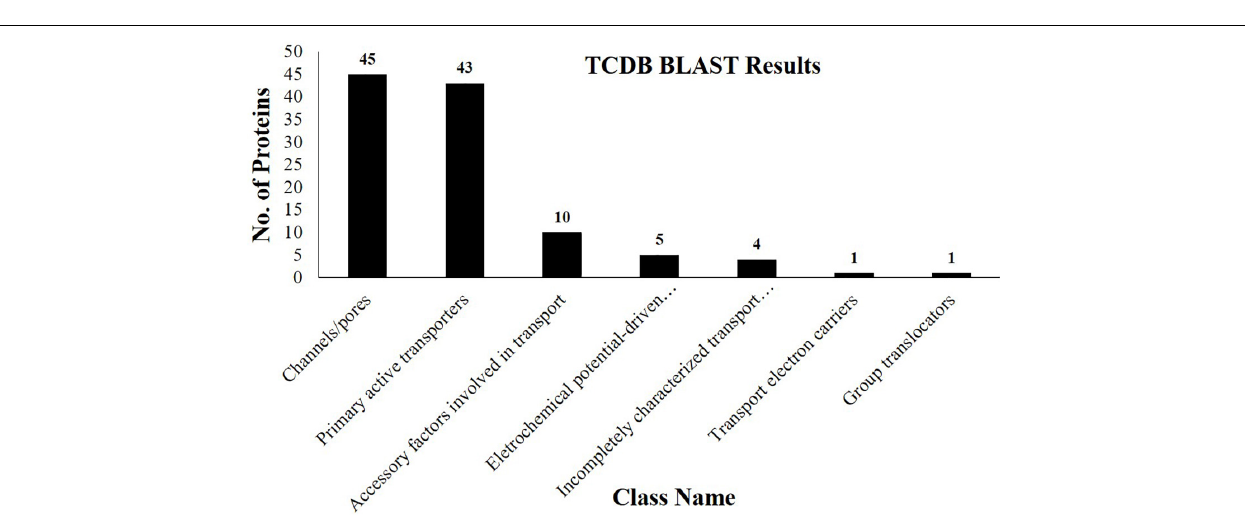
FIGURE 4 | Column graph showing the various classes of transporter proteins identified from the embryo of J. curcas seeds in accordance with the Transporter Classification Database